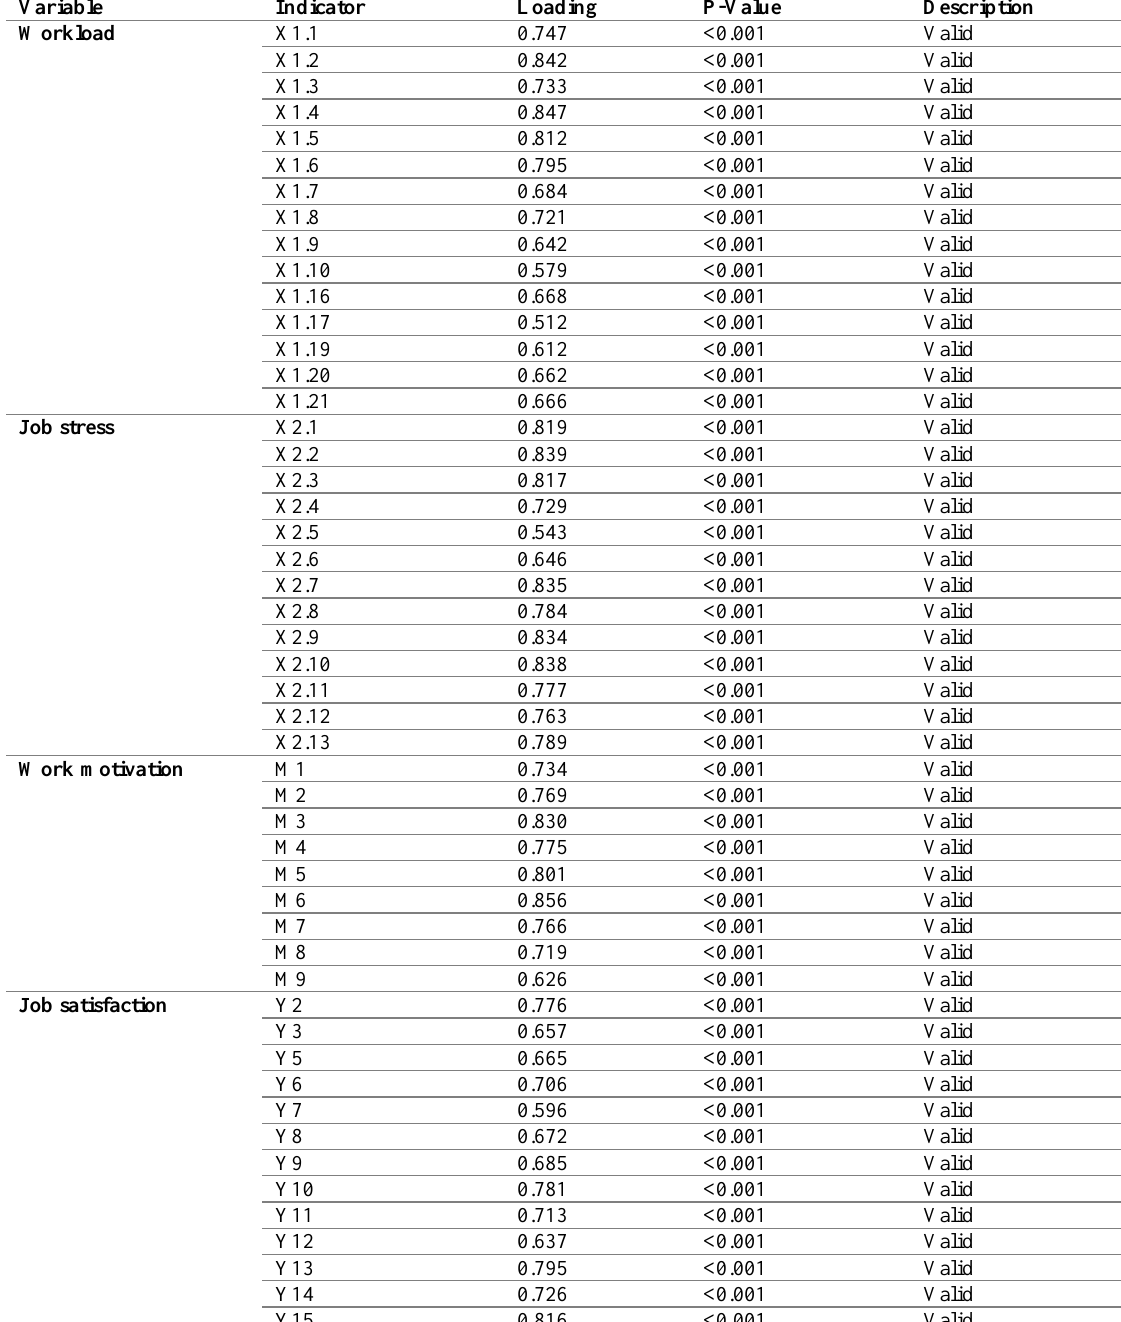
Table 2: Convergent Validity